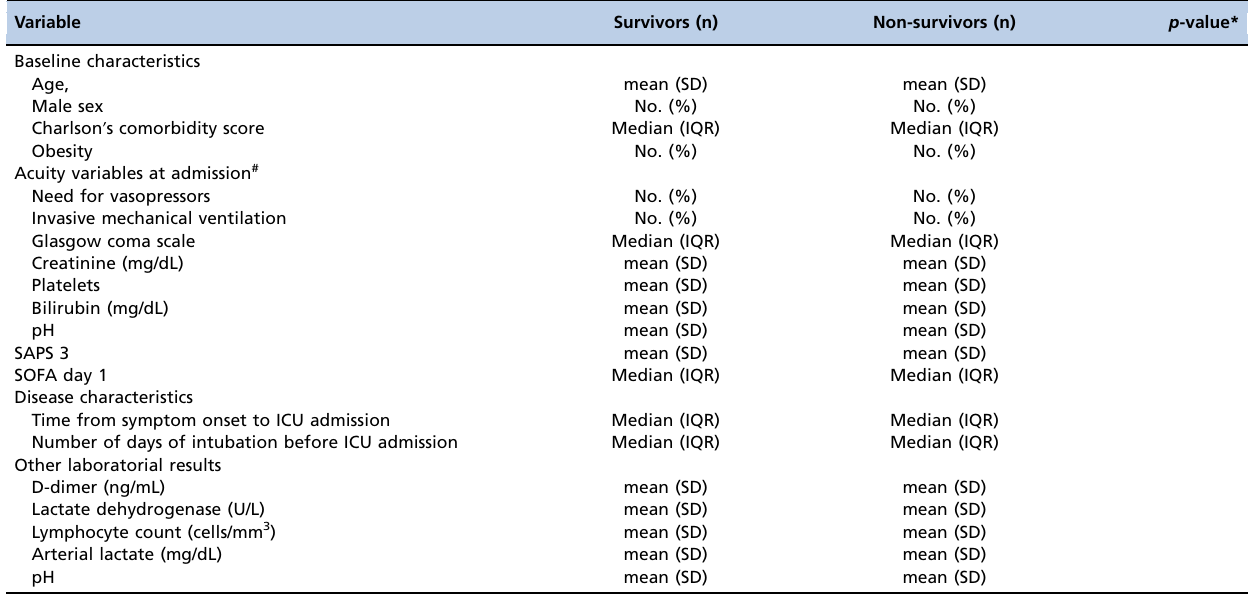
Table 5 - Predictors of ICU survival at 28